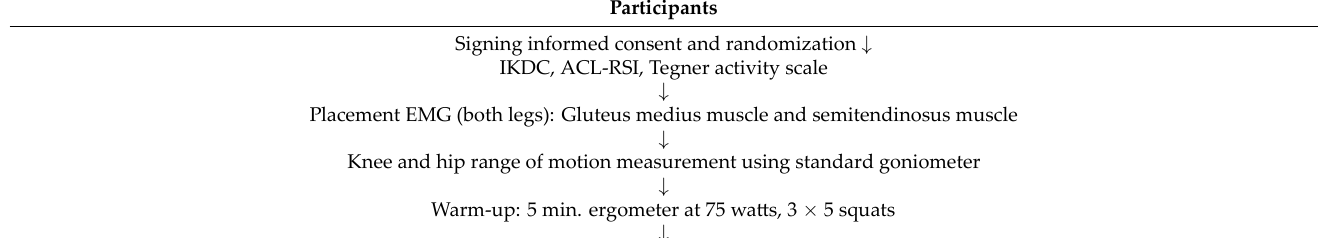
Table 2. Description of the planned consecutive activities during the measurement session